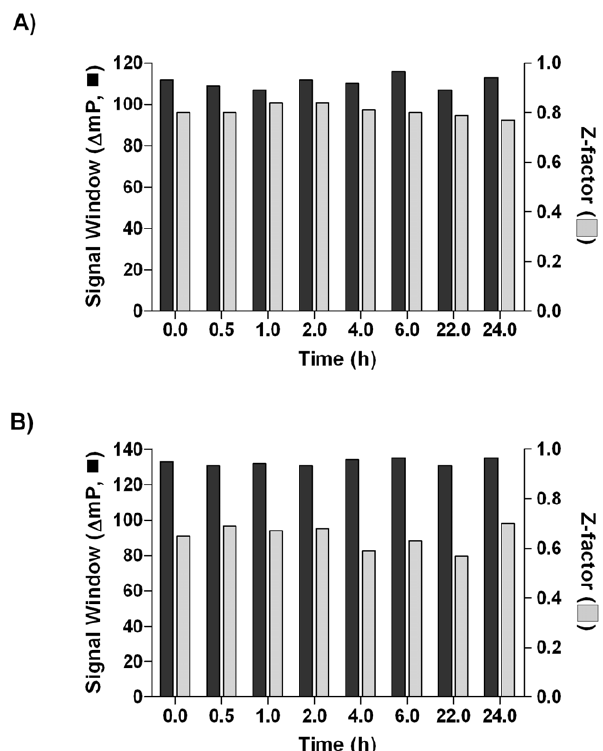
Figure 4. Reagent Stability as a Function of Storage Time. Signal window ( D mP) ( & ) and Z’-factor ( & ) were calculated from the FP values derived from the probe-only solution vs. protein-probe mixture for AGP (A) and HSA